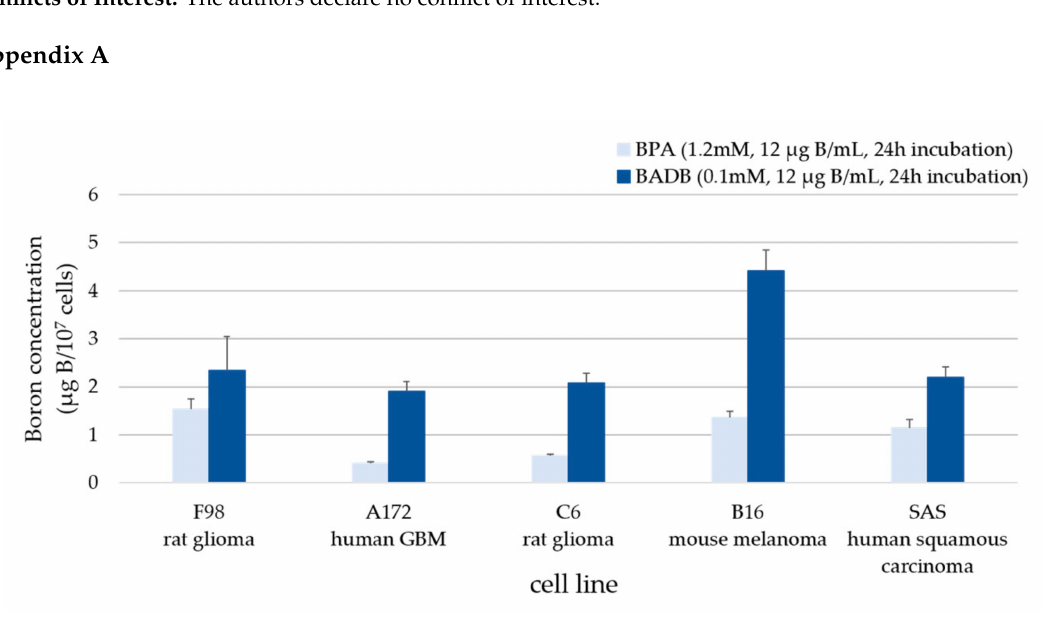
Figure A1. The boron concentration taken into the cell at each cell line 24 h after incubation in Dulbecco’s Modified Eagle’s Medium (DMEM), including 12 µ g B / mL of each boron compound. The boron concentrations of each cell line in the BPA and BADB groups were 1.54 ± 0.22 and 2.34 ± 0.71 µ g B / 107 cells (F98 rat glioma cells), 0.41 ± 0.03 and 1.90 ± 0.20 µ g B / 107 cells (A172 human glioblastoma cells), 0.56 ± 0.03 and 2.08 ± 0.21 µ g B / 107 cells (C6 rat glioma cells), 1.35 ± 0.14 and 4.41 ± 0.43 µ g B / 107 cells (B16 mouse melanoma cells), and 1.15 ± 0.17 and 2.20 ± 0.21 µ g B / 107 cells (SAS human squamous carcinoma cells),